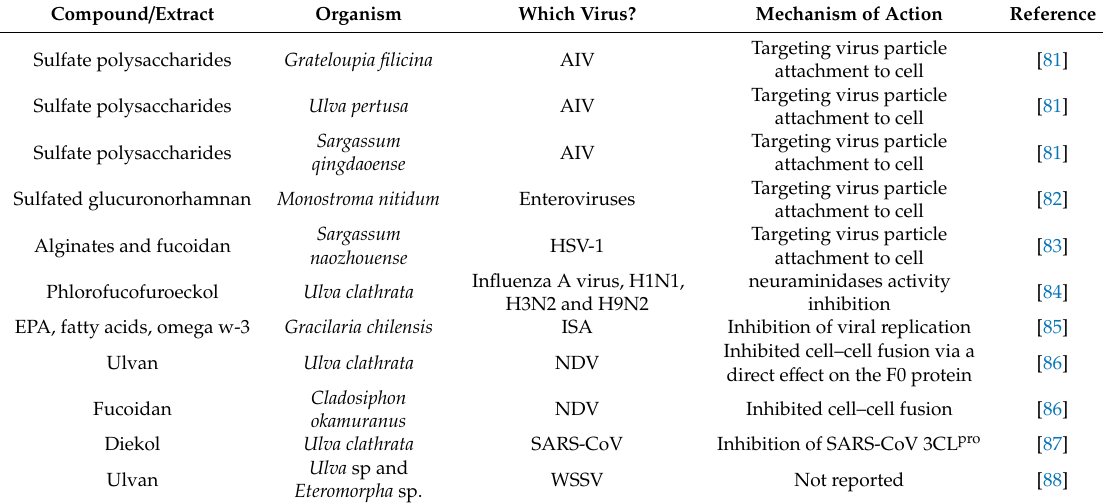
Table 4. Compounds with antiviral activity isolated from seaweeds. AIV, Avian Influenza virus; HSV-1, Herpes Simplex virus-1; ISA, Infectious Salmon Anemia; NDV, Newcastle disease virus; SARS-CoV, severe acute respiratory syndrome coronavirus replication; WSSV, White Spot Syndrome